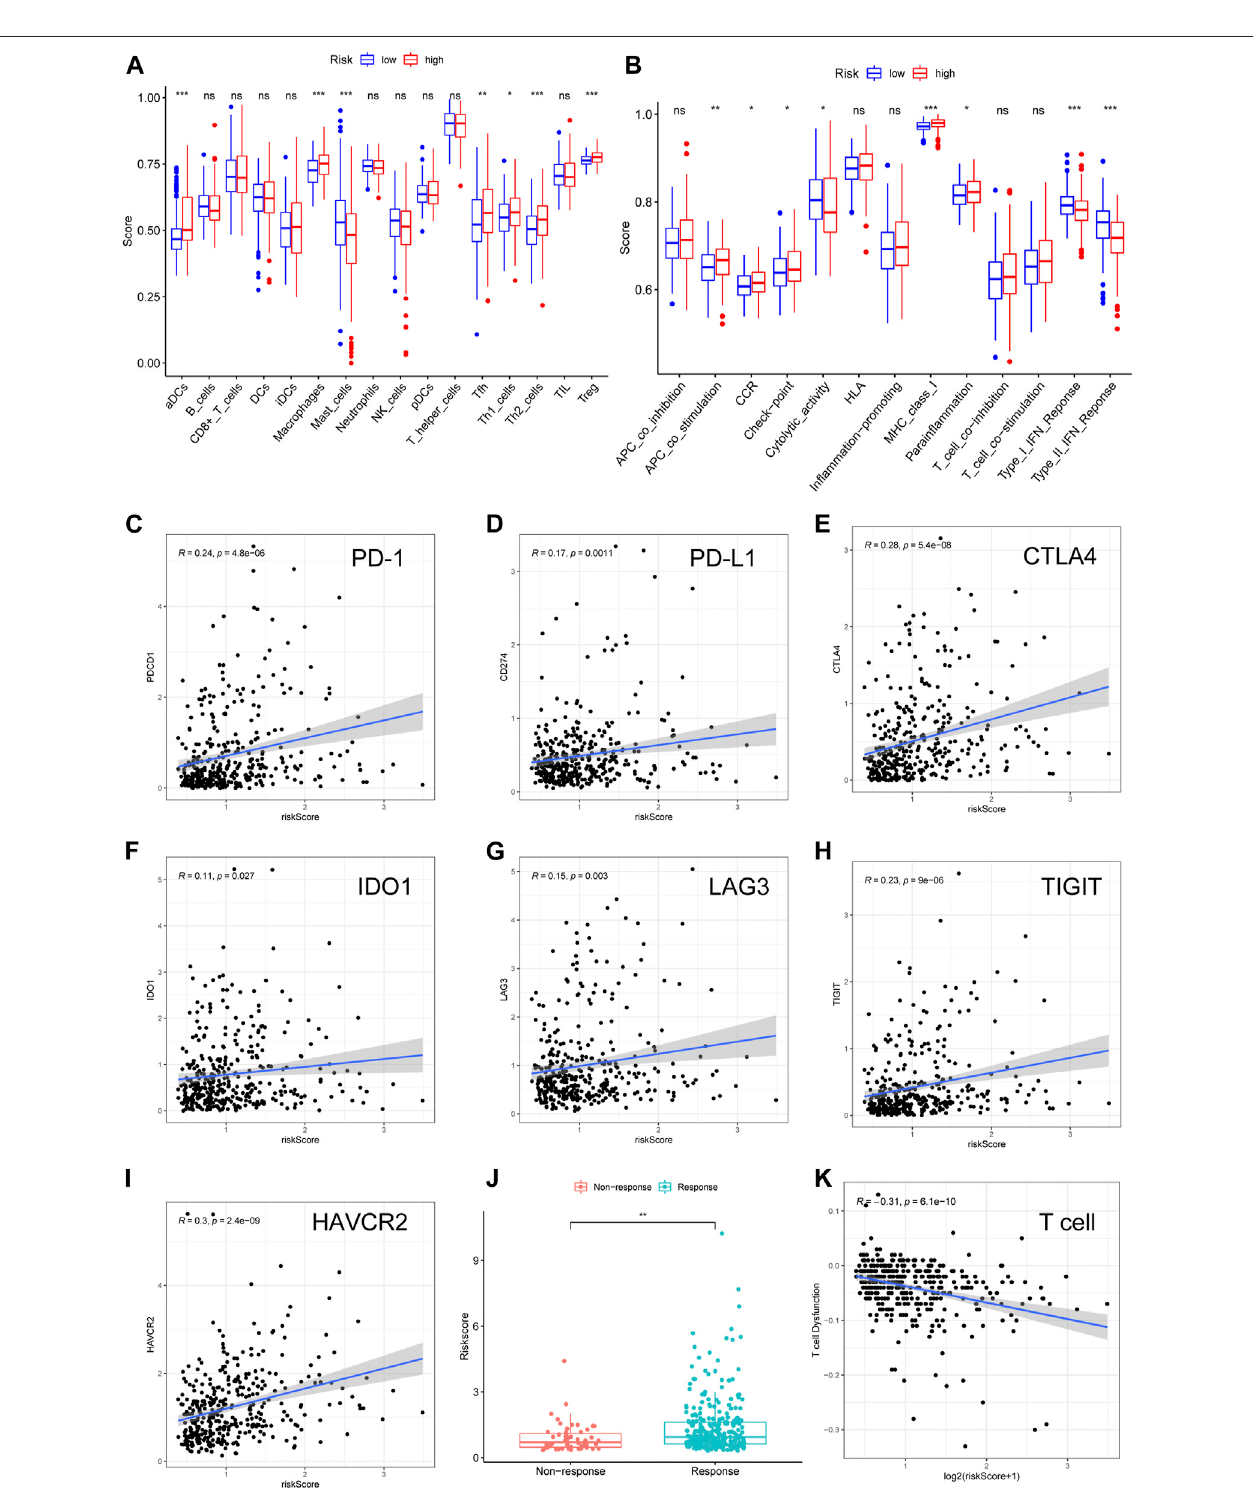
FIGURE 6 | Validation of the ferroptosis-related lncRNA model in TICs and immunotherapy. The scores of (A) 16 immune cell subpopulations and (B) 13 immune- related functions varied in the high- and low-risk groups. (C – I) The correlation between seven important checkpoint molecules and the risk scores of HCC patients. (J) TherelationshipbetweenriskscoreandresponsetoimmunotherapywasdeterminedusingtheTIDEalgorithm. (K) TherelationshipbetweenTcelldysfunctionandlog2 (risk score). lncRNA: long noncoding RNA; TIC: tumor-in fi ltrating immune cells; TIDE: tumor immune dysfunction and exclusion. Log2: data log2 transformed.